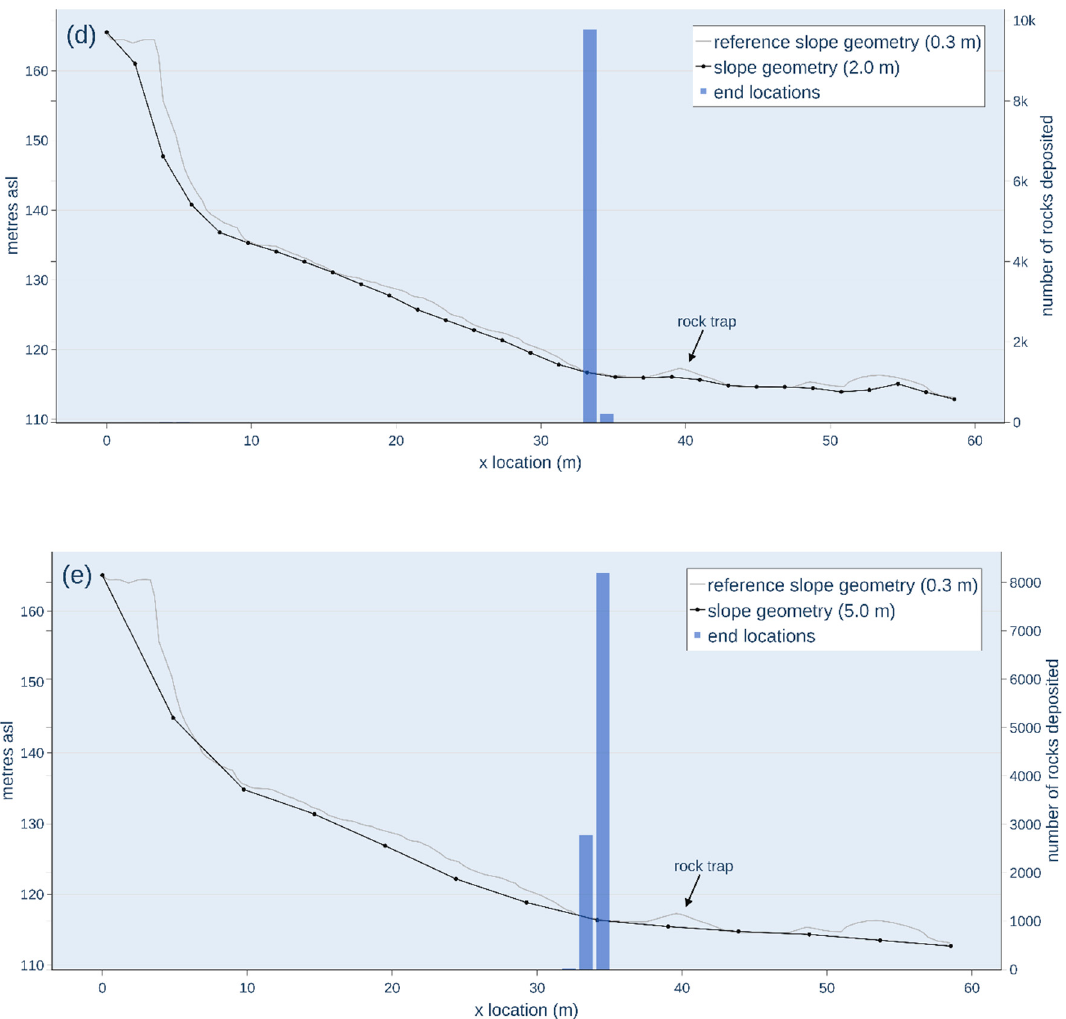
Figure 9. Results of the Rocfall 2D-LM. The plots show the distribution of end locations along the cross-section. The geometrical resolution adopted for each simulation run is as follows: ( a ) 0.3 m, ( b ) 0.5 m, ( c ) 1 m, ( d ) 2 m, ( e ) 5 m.